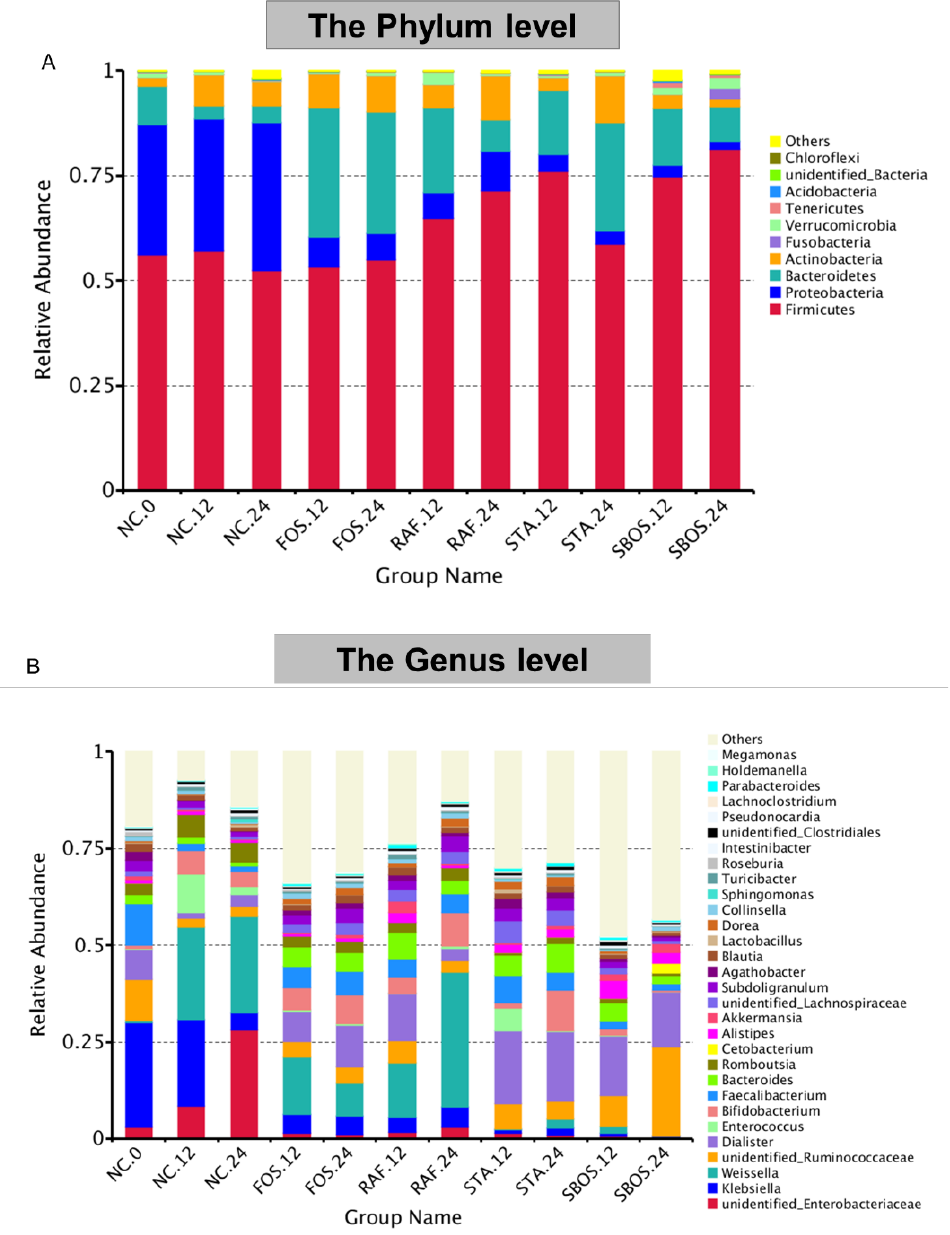
Figure 7. Intestinal microbial community structure: bar plot at the phylum level ( A ) and the genus level ( B ).